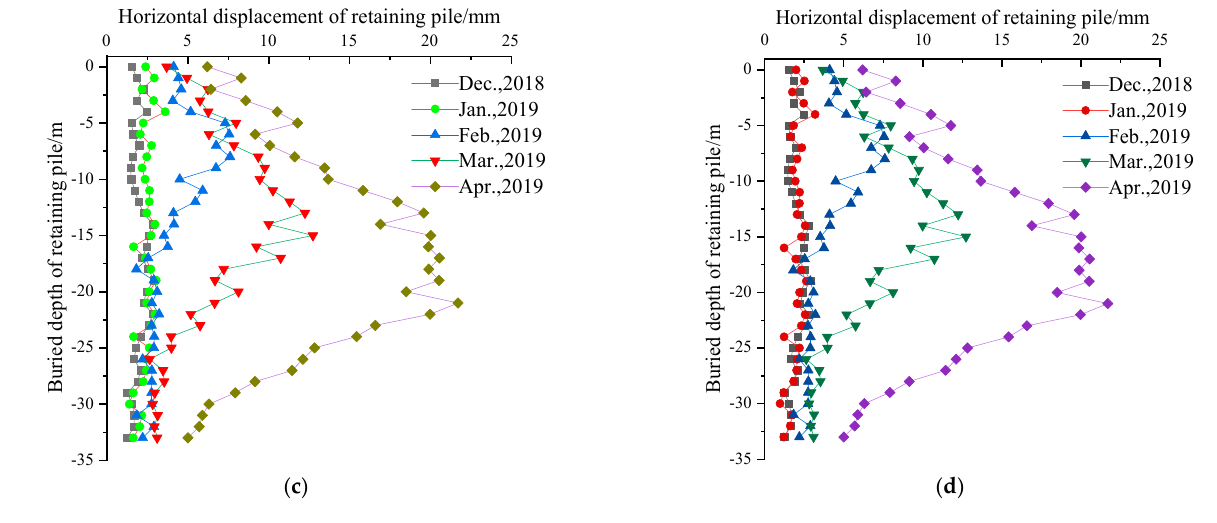
Figure 8. Vertical displacement time − history curve of each measuring point of the station.